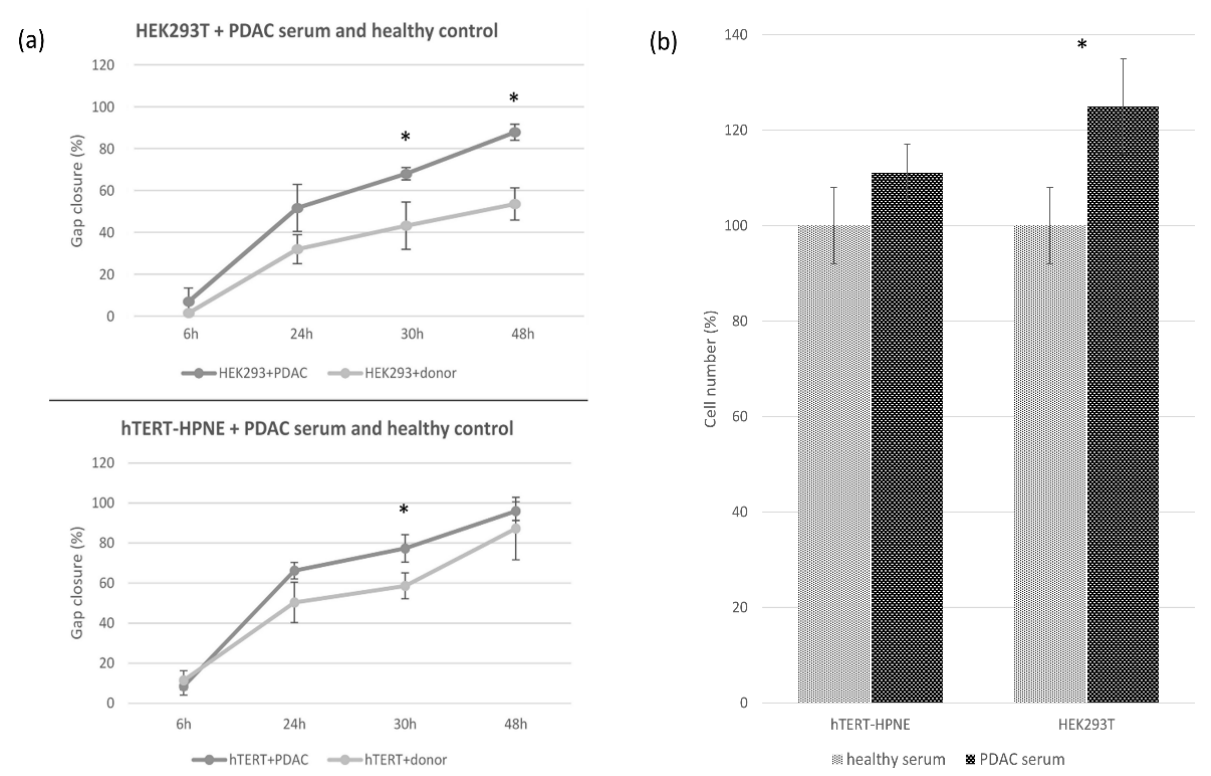
Figure 4. Migration ( a ) and invasion ( b ) assays. Graphical representation of mean values with standard deviation for HEK293T and hTERT-HPNE cell lines treated with PDAC serum compared to healthy serum. Significant differences ( p < 0.05) are marked with an asterisk.